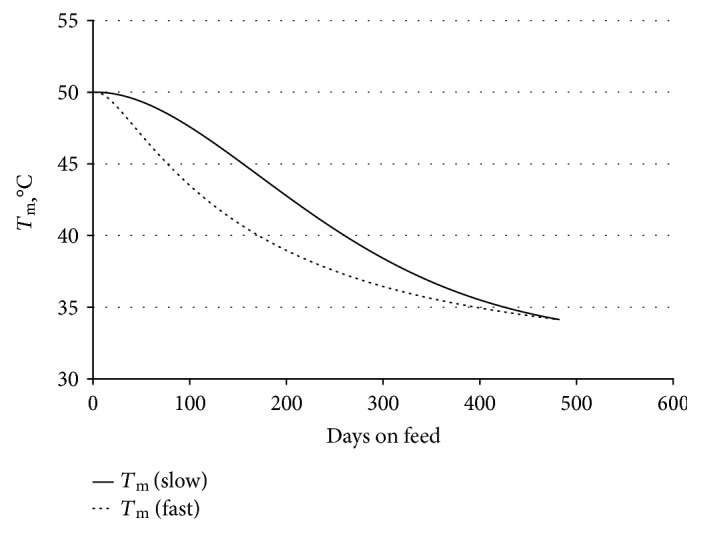
Match to desaturation model of fat melting point. The Tm decrease shown in Figure 7 can be described by the following mathematical model of fat production and desaturation. De novo fat production is controlled by FASN, in response to energy balance. This fat starts saturated. It is then desaturated by the SCD enzyme. The total fat present (F) can be described by dF/dt = a, where a is the rate of de novo fat production. The amount of unsaturated fat (U) increases in proportion to the amount of desaturation enzyme E as dU/dt = E. In this model, the amount of enzyme available is increased in response to the amount of saturated fat present, and also decays. The amount of enzyme is described by dE/dt = bS − cE, where b and c are constant control parameters and S = F − U is the amount of fat that remains unsaturated. The melting point decreases with increasing proportion of unsaturated fat. Tm decreases in proportion to the amount of unsaturated fat, Tm = TΔ and S/F + TU. The melting point curves resulting from this model have an initial high Tm decreasing slowly at first and then more rapidly as the desaturation enzyme builds up. This figure shows how the model reacts to parameter changes. The fast enzyme response with parameters b = .001 and c = .1 looks similar to the Tm curve shown in Figure 8, TCAP 20 homozygotes. A slower enzyme response has parameters of b = .0001 and c = .01 is more similar to the Tm curve for TCAP 10 homozygotes. TCAP is already known to be involved in pathways regulating the production of the SCD enzyme, so it influencing the Tm in this way is not surprising.